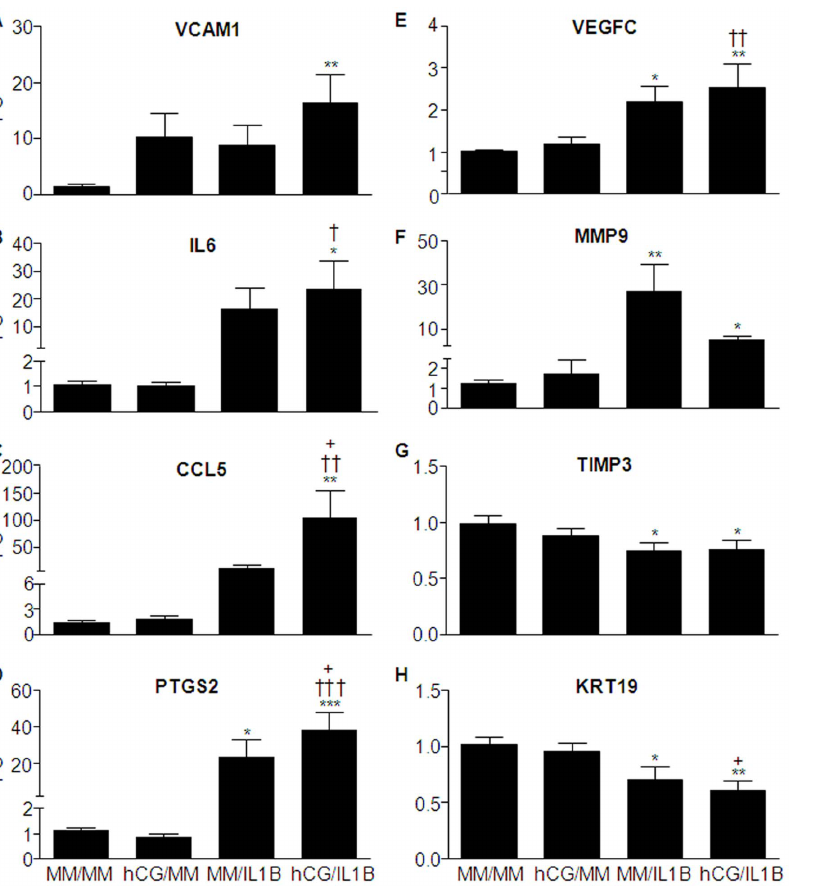
Figure 4. hCG modulates the IL1B-mediated mRNA expression of immune modulating, adhesion, growth, angiogenic and tissue remodeling factors in ESCs. Confluent ESC cultures were incubated with minimal medium (MM) (control) or hCG (100 ng/mL) for 24 h before being exposed or not to IL1B (0.1 ng/mL) for additional 24 h. Total RNA was extracted and reverse transcribed, and mRNA levels were then quantified by qRT-PCR. VCAM1 (A), IL6 (B), CCL5 (C), PTGS2 (D), VEGFC (E), MMP9 (F), TIMP3 (G) and KRT19 (H) mRNA ratio was then determined following normalization to GAPDH mRNA (internal control). Data were from ESC cultures issued from 7 different subjects and expressed as fold change (FC) over control (ratio of VCAM1, IL6, CCL5, PTGS2, VEGFC, MMP9, TIMP3 or KRT19 mRNA levels found in cells incubated with IL1B, hCG or hCG/ILB to those found in cells incubated with MM for an equivalent period of time). *P , 0.05, **P , 0.01, *** P , 0.001 relative to MM; { P , 0.05, {{ P , 0.01, {{{ P , 0.001 relative to cells stimulated with an equivalent concentration of hCG; + P , 0.05 relative to cells stimulated with an equivalent concentration of IL1B. Data were obtained with ESC cultures issued from 7 different subjects (the 3 cultures used for microarray analysis and 4 additional